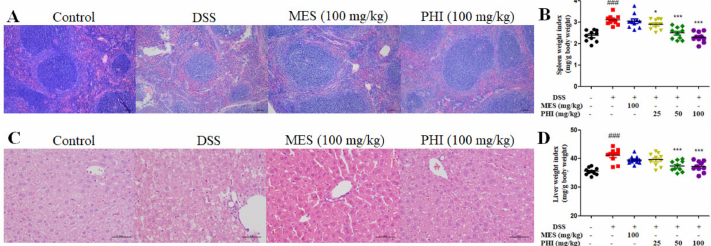
Figure 3. PHI improved the pathological damages of spleen and liver. ( A ) Representative spleen histological sections (scale bar = 100 µ m). ( B ) Spleen index of each group mice. ( C ) Representative liver histological sections (scale bar = 50 µ m). ( D ) Liver index of each group mice. ### p < 0.001 vs. control group. * p < 0.05and *** p < 0.001 vs. DSS group. ( n = 10 mice per